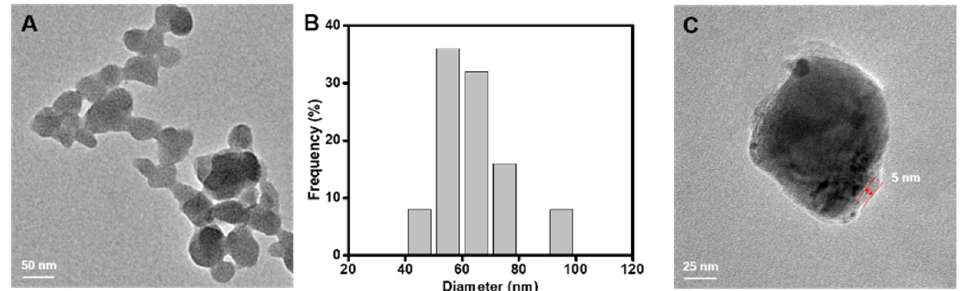
Figure 2. ( A ) TEM images of Cu-MOF. Scale bar: 50 nm. ( B ) The size distribution of Cu-MOF as measured by TEM image. ( C ) TEM images of Cu-MOF/GOD@HA (Scale bar: 25